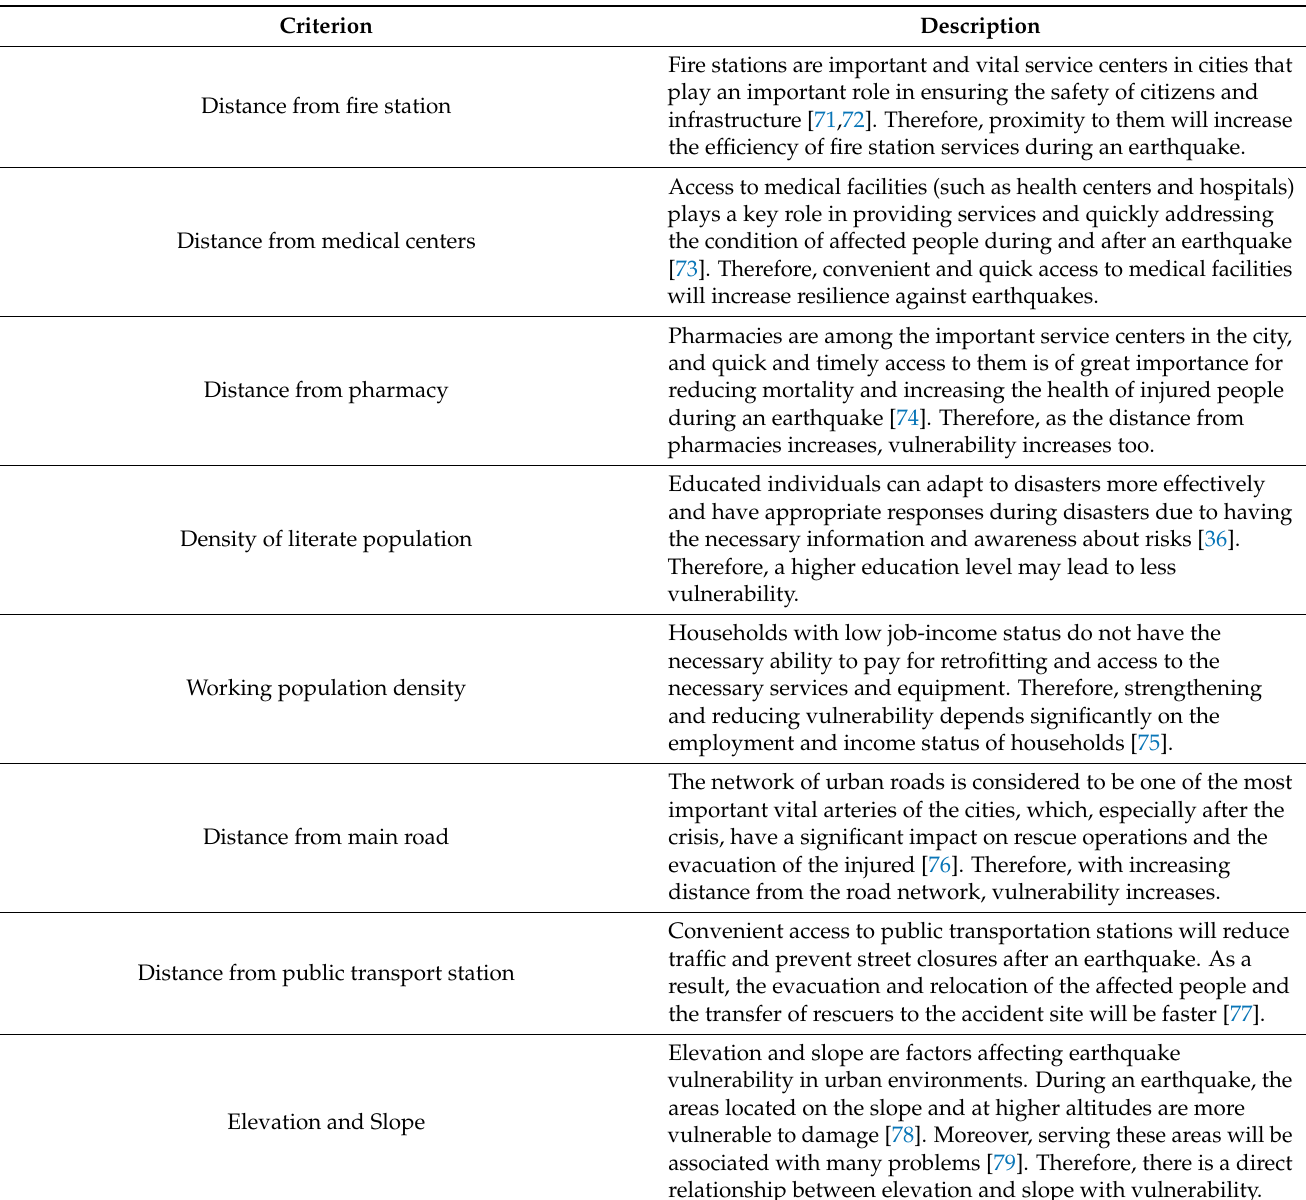
Table 2. The criteria used in this